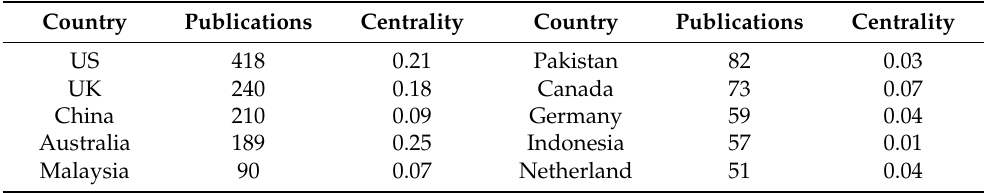
Table 1. Top 10 countries/regions based on the number of publications.